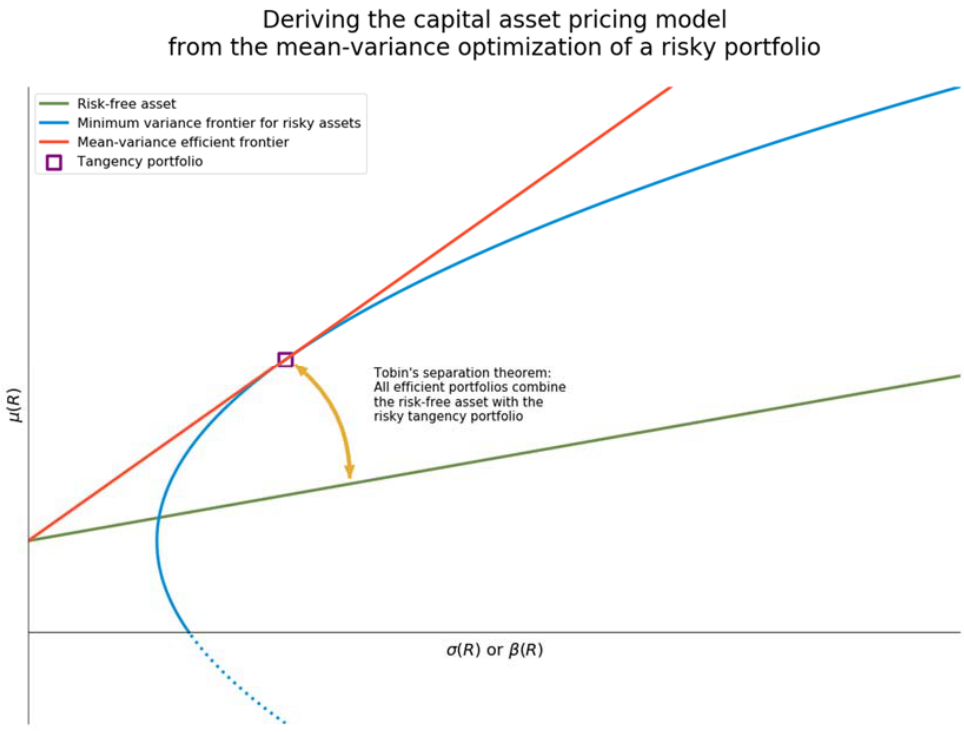
Figure 1. Deriving the CAPM from the mean-variance optimization of a risky portfolio.